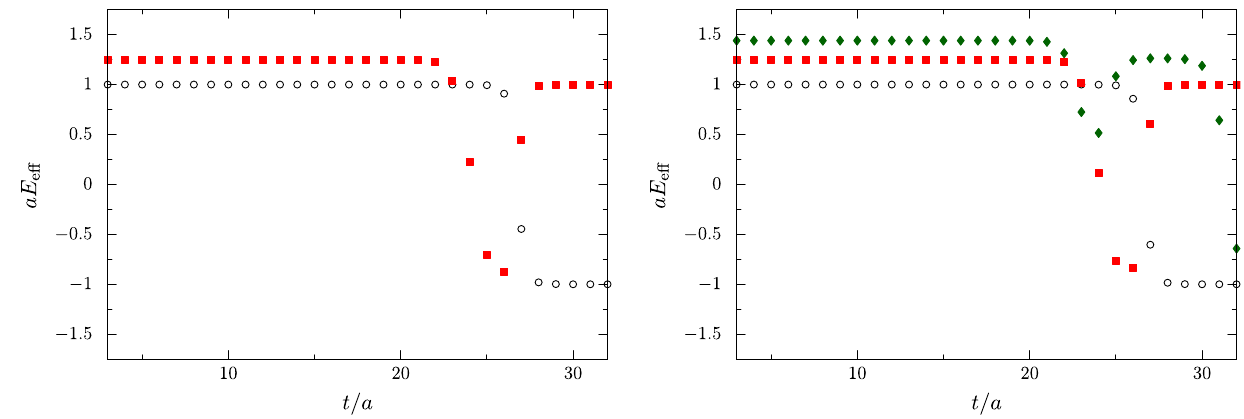
Fig. 1 Effective masses obtained from the 2 × 2 subsystem (left panel) and the 3 × 3 subsystem (right panel) of our toy model, with T = 64 and t 0 =